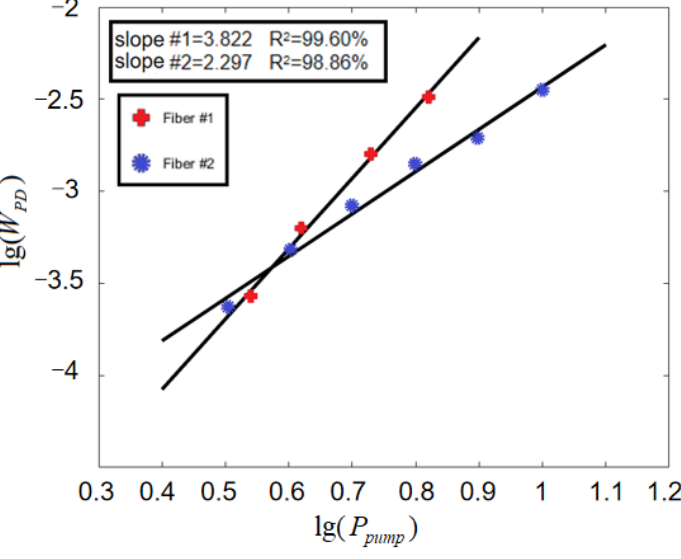
Figure 4. Logarithmic relationship between 𝑊 𝑃𝐷 and 𝑃 𝑝𝑢𝑚𝑝 .